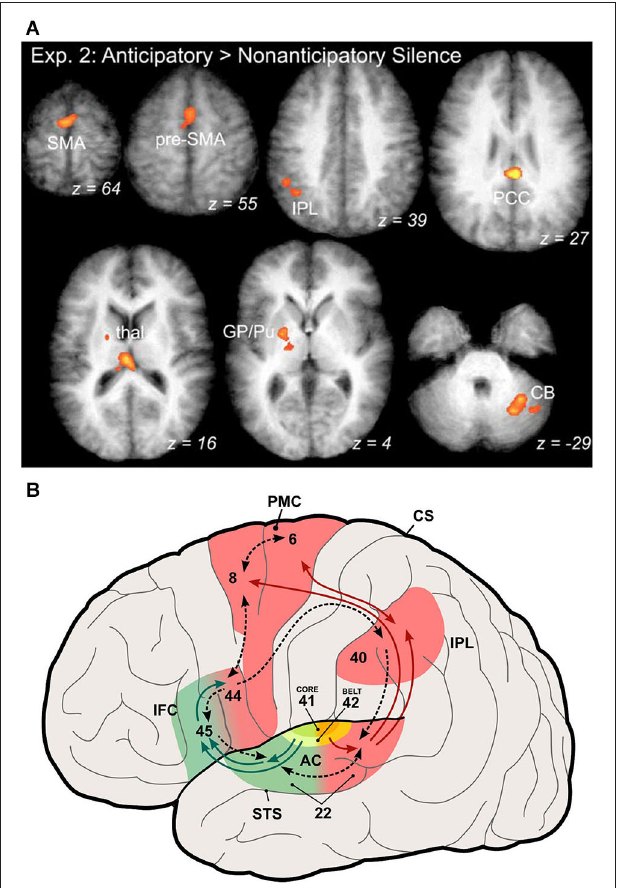
FIGURE 2 | Participation of auditory dorsal stream in coding of musical sequences. (A) Activation of areas in the auditory dorsal stream by anticipation of familiar music. Activated areas include the supplementary and pre-supplementary motor areas (SMA, pre-SMA), the inferior parietal lobule (IPL), posterior cingulate cortex (PCC), globus pallidus and putamen (GP/Pu) of the basal ganglia, and the cerebellum (CB) (from Leaver et al., 2009). (B) Illustration of the auditory ventral and dorsal streams in the human brain (modified from Rauschecker and Scott, 2009). This expanded model originated from the original dual-pathway model of Rauschecker and Tian (2000) by generalizing the role of the dorsal stream to one of sensorimotor integration and control, which includes processing of space and motion as well as storage and retrieval of sound sequences, the latter especially relevant for processing of